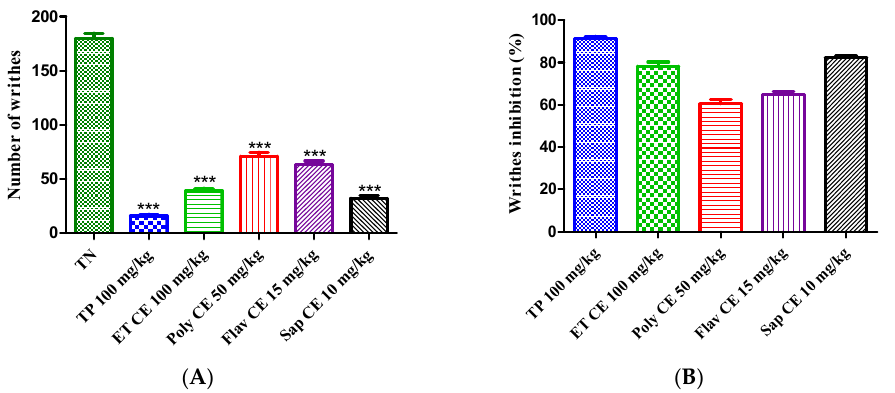
Figure 4. Antinociceptive activity of the C. europaea extracts on mice’s writhing behavior induced by acetic acid. ( A ) Number of abdominal contractions. ( B ) Inhibition of abdominal contractions in the treated groups. Values are expressed as mean ± SEM. Results are statistically different from the negative control ***: p <